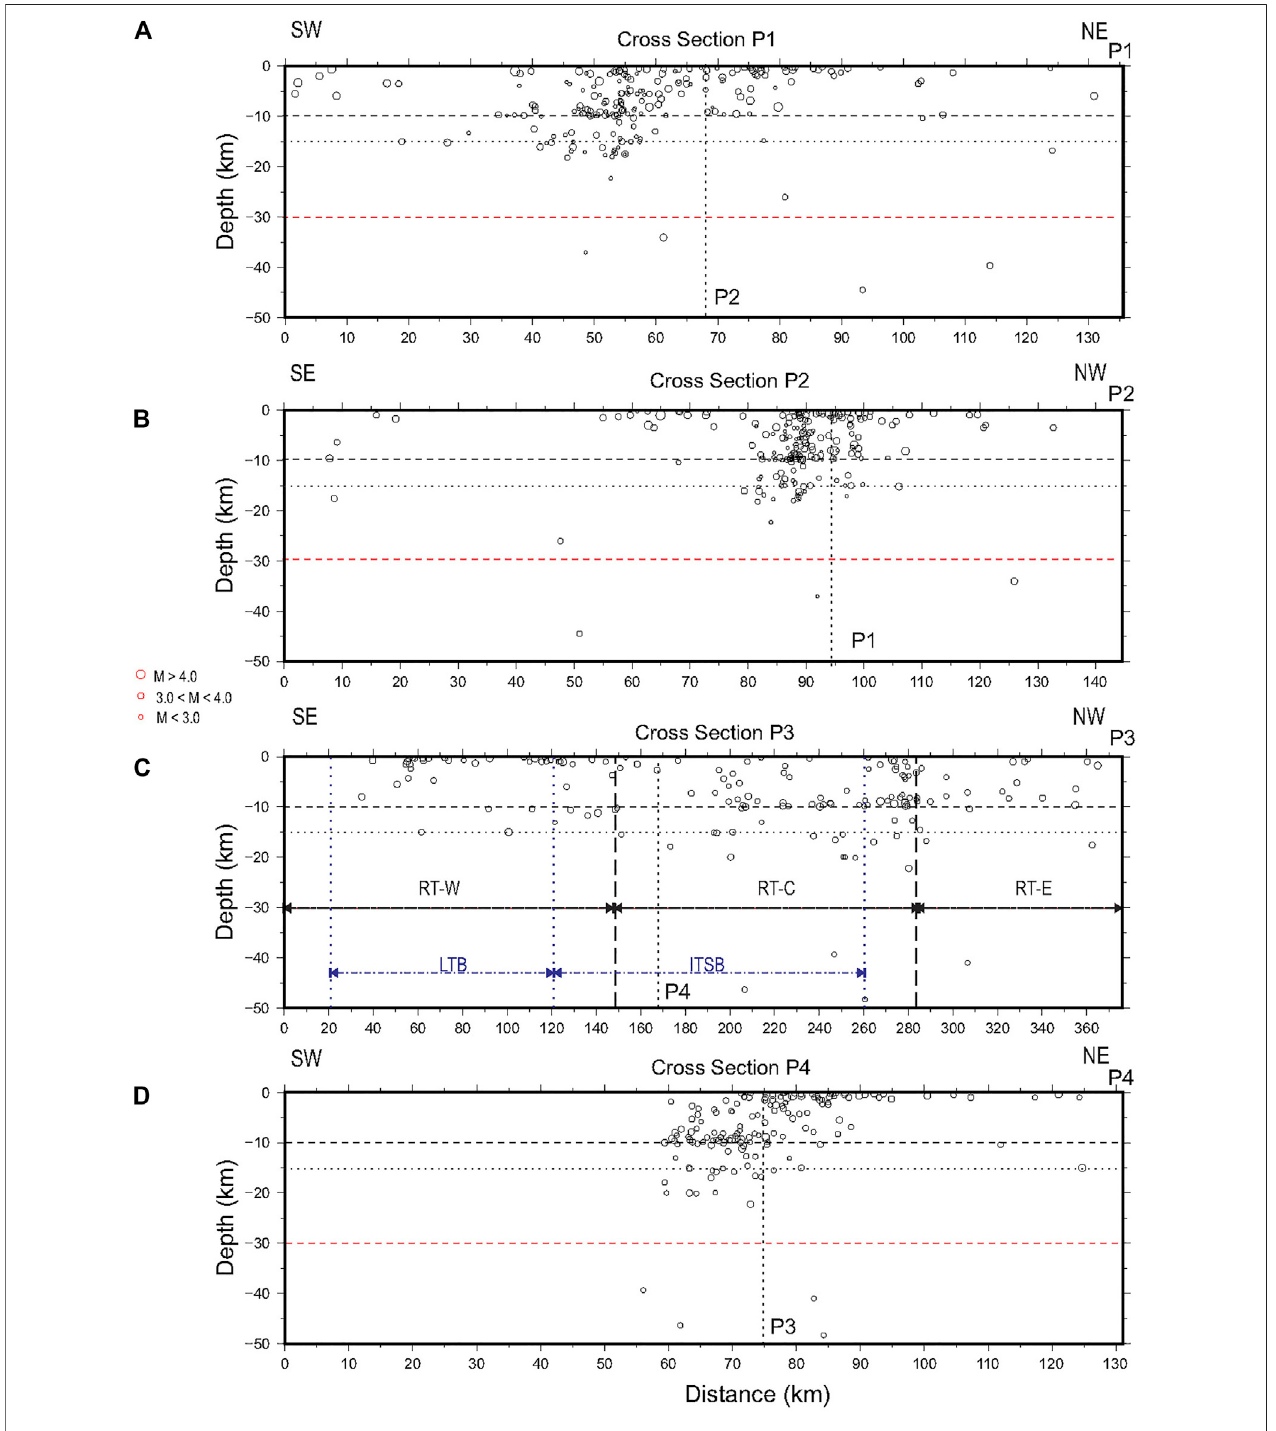
FIGURE 8 | Seismicity projections along P1, P2, P3, and P4 transects, whose locations are shown in Figure 7 . (A) Hypocentral cross-section along line P1; (B) Hypocentralcross-sectionalonglineP2; (C) Hypocentralcross-sectionalonglineP3,ITSB:Intra-TransformSpreadingBasin.LTB:LeakyTransformBasin(Bandyetal., 2011); (D) Hypocentral cross-section along line P4. Dashed horizontal lines at 10, 15, and 30 km used as Earthquakes registered by the OBS array were identi fi ed using the Antelope system (Lindquist et al., 2007) through a short-term average/long-term average signal energy algorithm with a STA